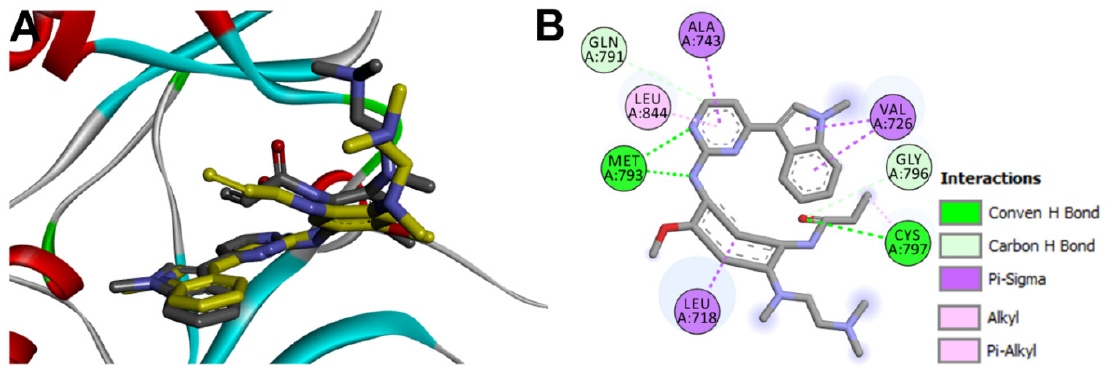
Figure 10. Binding mode/interactions of osimertinib into the active site of EGFR (pdb: 4ZAU): ( A ) 3D binding mode of the redocked osimertinib (shown as sticks colored by element) overlaid with the co-crystallized ligand (yellow sticks); ( B ) 2D binding mode of the co-crystallized osimertinib showing the binding interactions with amino acids in the active site of EGFR.